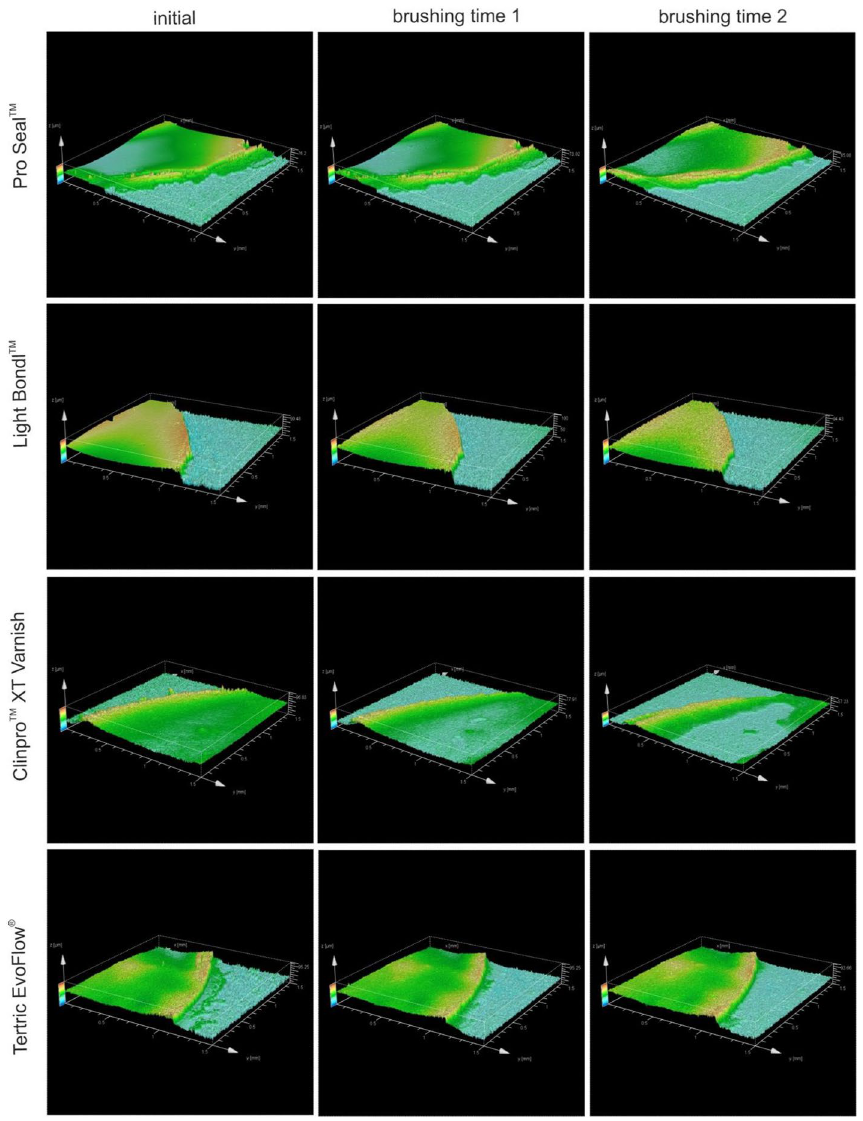
Figure 5. 3D images of the sealants surface topography of Pro Seal, Light Bond, ClinPro and Tetric EvoFlow determined by optical